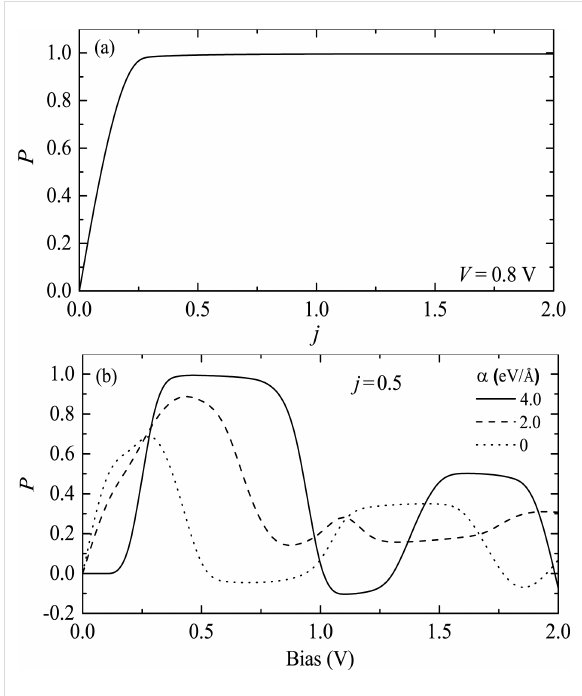
Figure 4: (a) Spin polarization of the current as a function of the spin coupling strength j for a bias of 0.8 V. (b) Bias-dependent spin polari- zation of the current for three different values of the electron–lattice coupling strength α . Reproduced with permission from [31], copyright 2007 American Physical